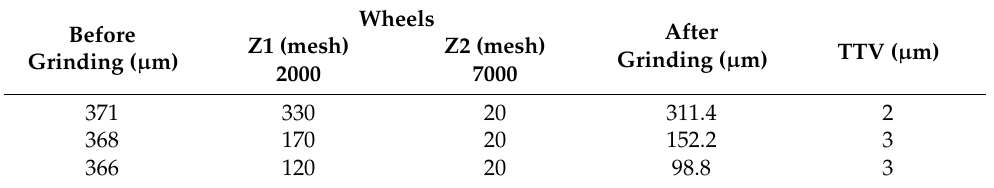
Table 1. Thickness of the SiC wafer prior to and after grinding.